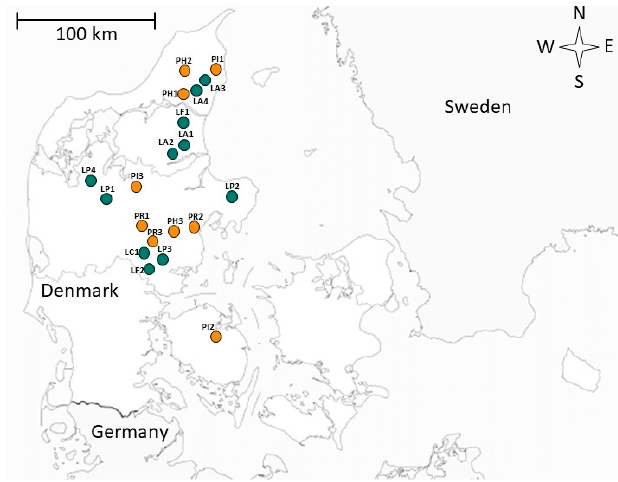
Figure 1. Sampling locations in Denmark. Orange and green markings indicate stormwater retention ponds (SWRPs) and natural, shallow lakes, respectively. Letter and number identification can be found in Table 1. Classification of SWRPs and natural, shallow lakes. Invertebrates taxa collected and analyzed for PAHs.